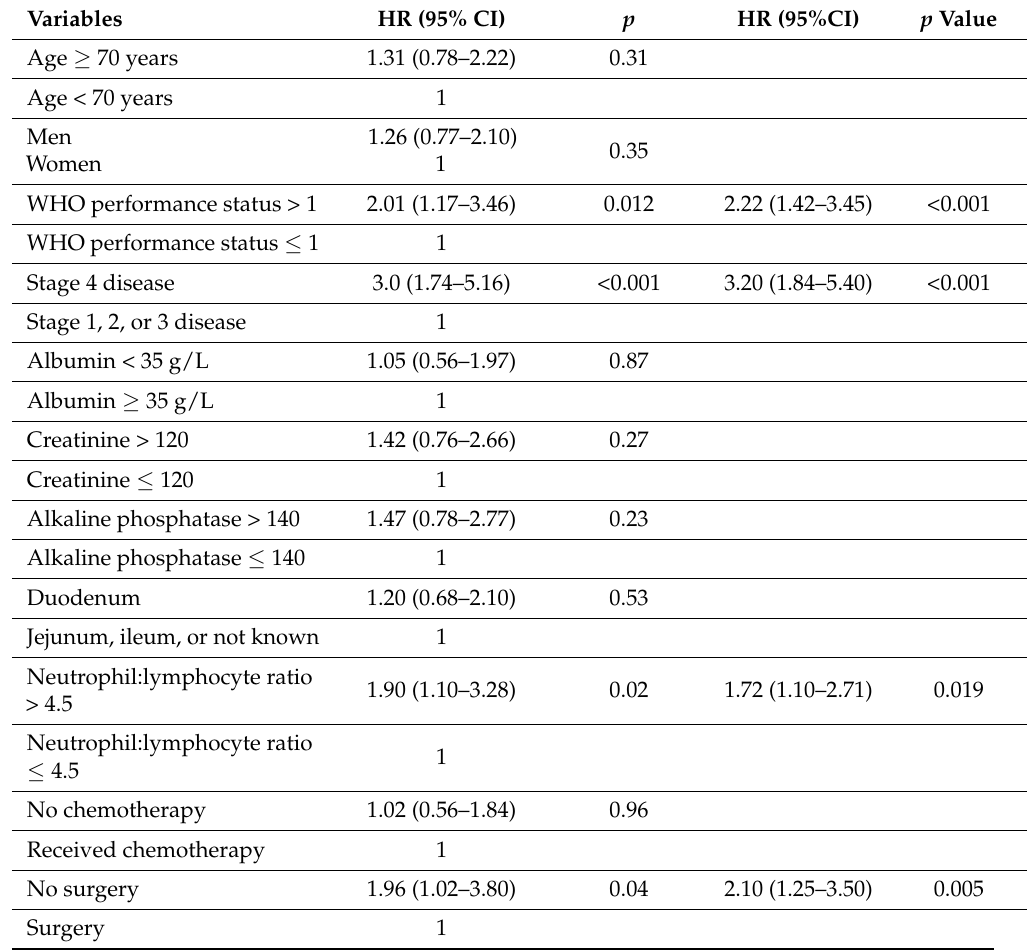
Table 3. Cox regression multivariate analyses and modelling of various clinical and pathological variables and their relationship with overall